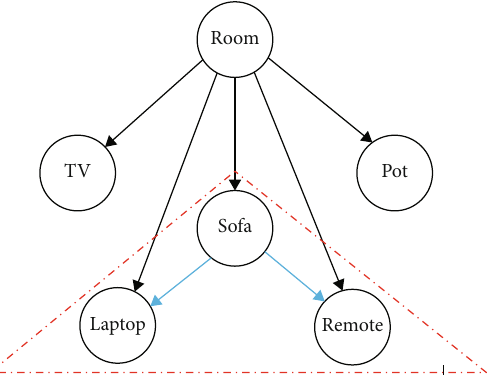
Figure 14: Scene graph representation associated with the fi rst case study. Dark arrows represent the absolute position of the objects with respect to the room coordinate frame system. The colored arrows represent the relative position of the object. Objects in the dashed enclosure represent an example of objects which can be clustered together.